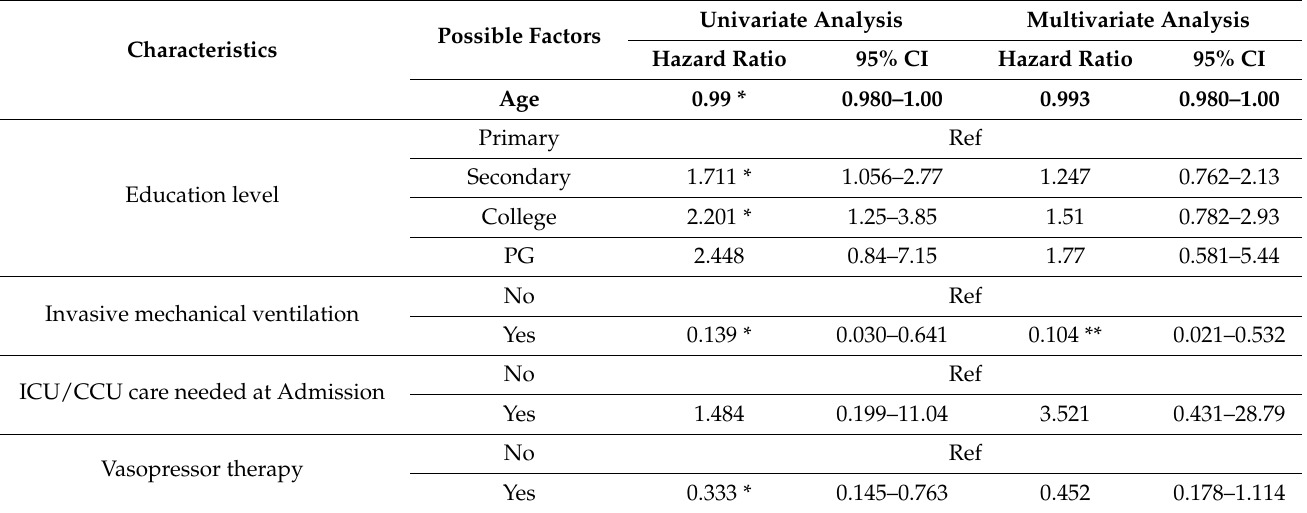
Table 5. Results of Cox univariate and multiple regression analyses of factors that are potentially associated with >24 h delay in presentation to the emergency department and 28-day mortality